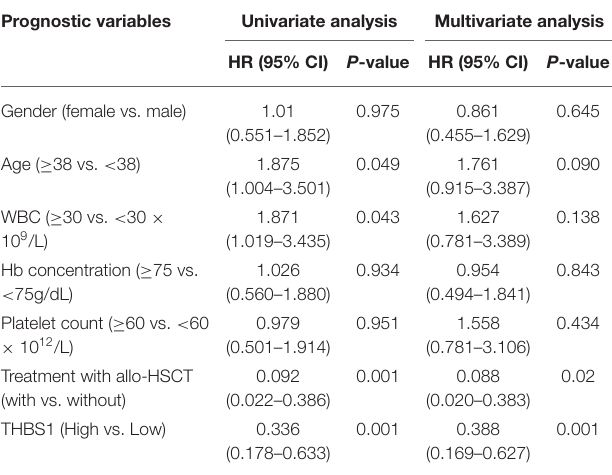
TABLE 2 | Univariate and multivariate analyses of the overall survival of patients. Prognostic variables Univariate analysis Multivariate